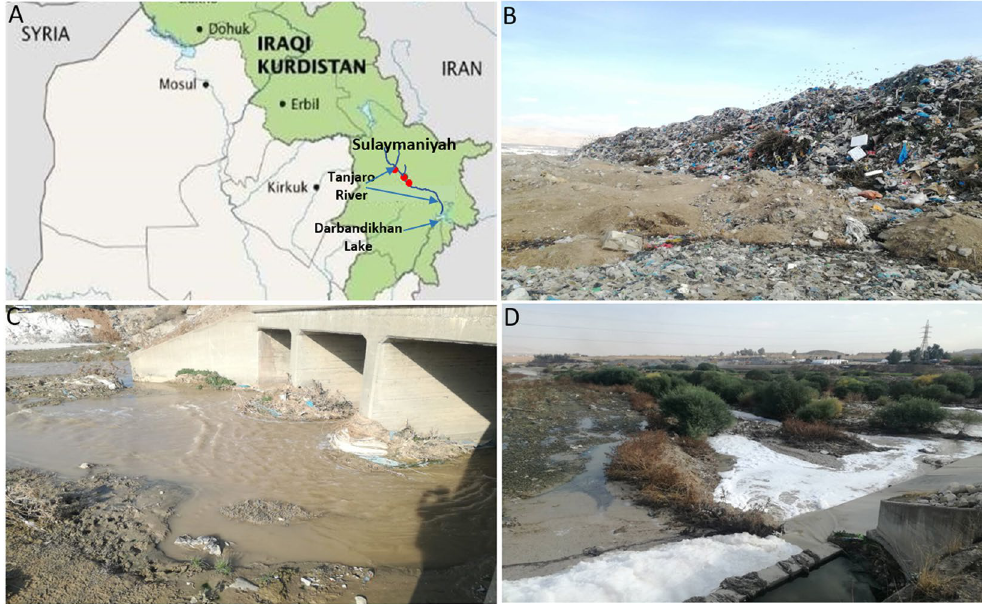
Figure 5. Map and location of sampling site. ( a ) Map showing Tanjaro River (blue arrow) and the sampling sites (red circles). ( b – d ) Images from the Tanjaro